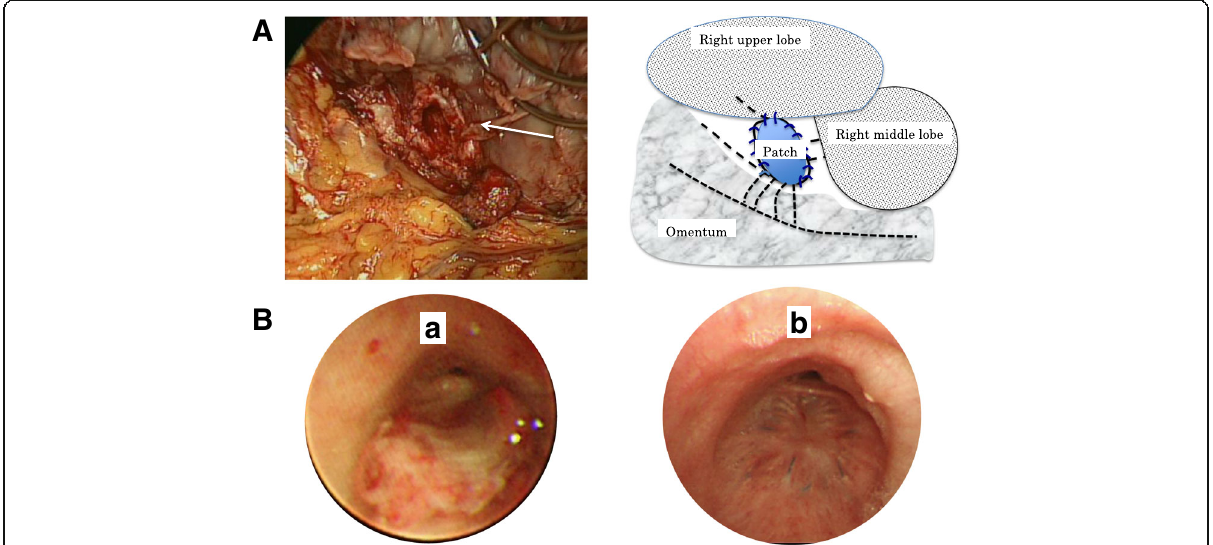
Fig. 2 Intraoperative and postoperative findings. A Intraoperative photograph and schema showed a BPF (arrow) in the right lower bronchus. The schema of the bronchial stump was closed using a pedicled gastric seromuscular flap and the omentum. B Bronchoscopy showed the patch closure using the gastric seromuscular layer. a 5 days after surgery. b 125 days after